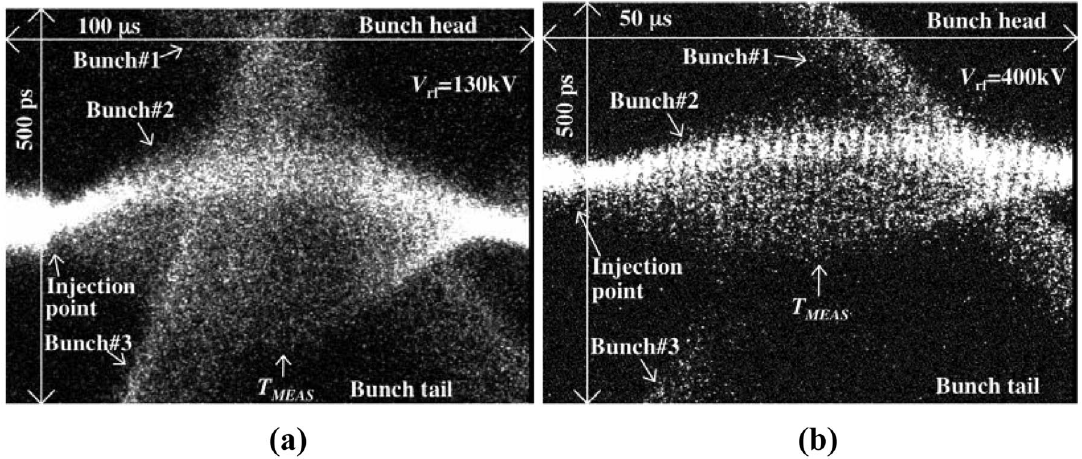
(cid:2) 130 kV ) and (b) uses a high rf rf